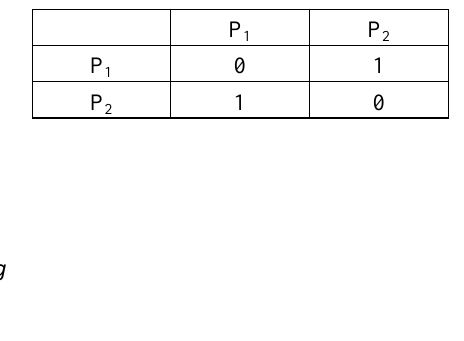
Table 1: Binary Dependency Matrix for {P 1 , P 2